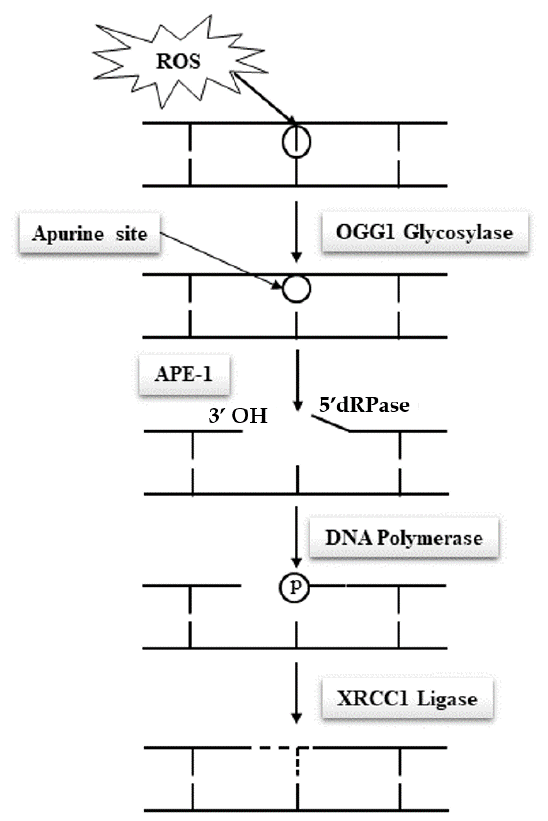
Figure 4. A representation of the base excision repair (BER) pathway. In this pathway, the oxidized bases are identified and removed with the help of the OGG1 glycosylase, and the APE1/XRCC1 recombinase. Spermatozoa possess only the first part of the BER pathway, but lack the APE-1/XRCC1 activities [46]. ROS: reactive oxygen species; APE-1: apyrimidinic/apurinic endonuclease 1; 5′dRPase: 5′-terminal deoxyribose phosphatases; XRCC1: X-ray repair cross- complementing.